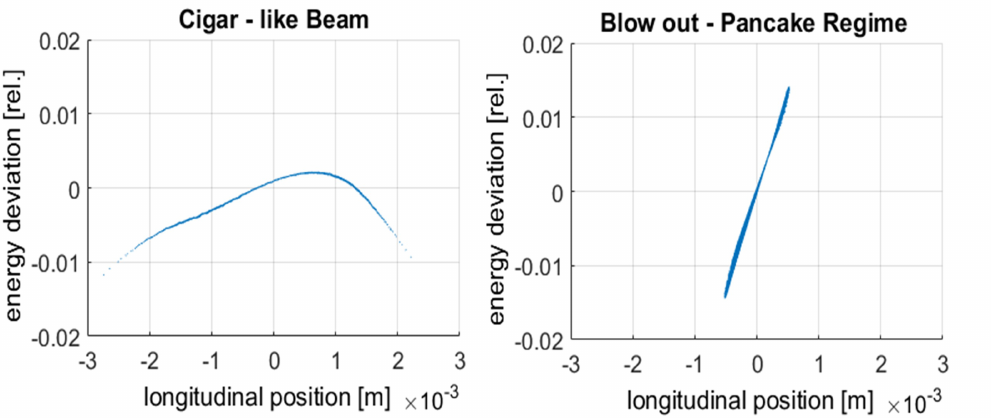
Figure 10. Examples of electron bunches (Q = 20 pC) produced in the ARES RF gun by using different settings of the photo-cathode laser. By using a cigar-like shaping of the photo-cathode laser the slice emittance and the slice energy spread of the beam is minimized, whereas by working in the blow-out regime the longitudinal phase space becomes linear.